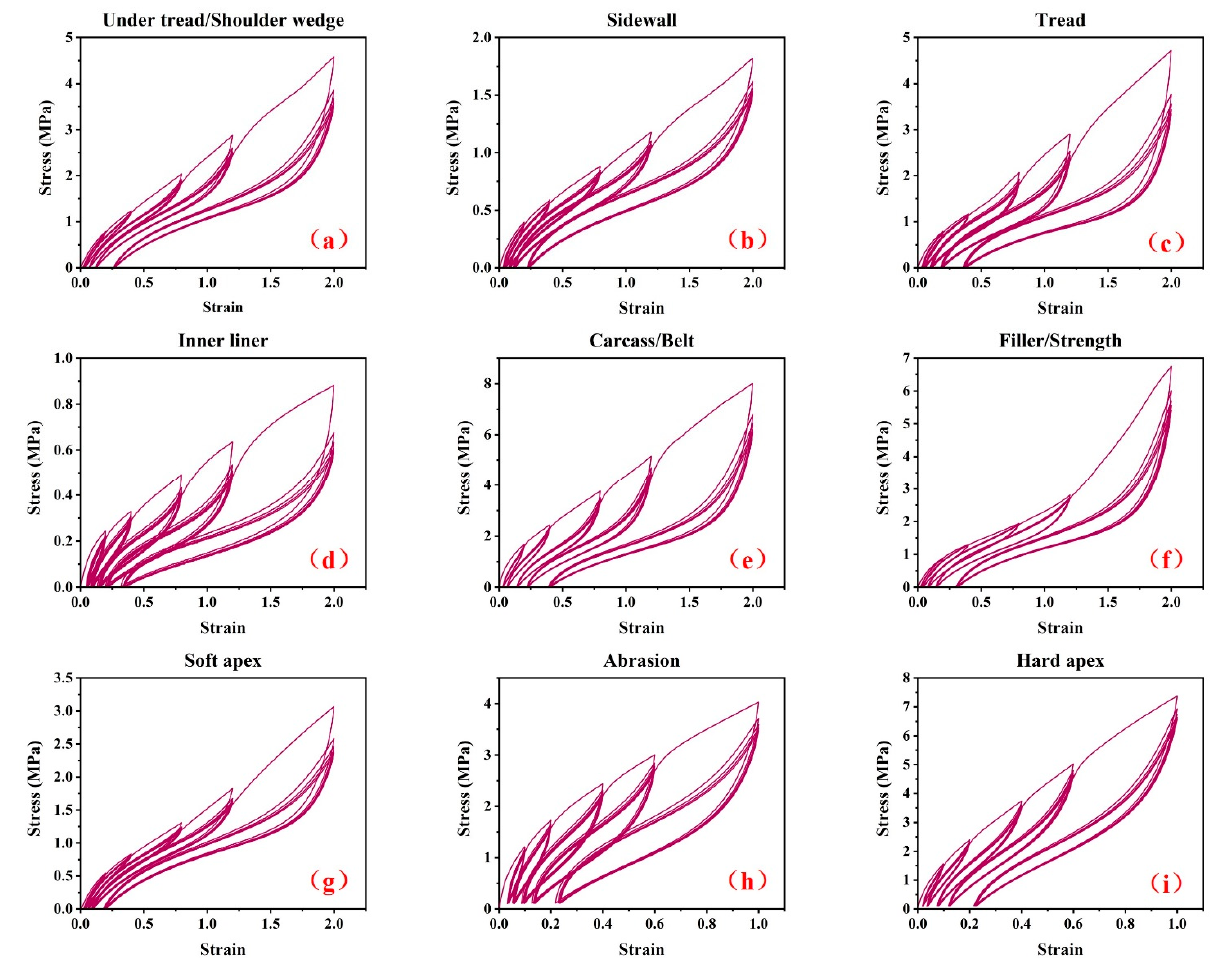
Figure 3. The raw stress–strain curves for nine different rubber specimens from TBR tire. ( a ) under tread and shoulder wedge, ( b ) sidewall, ( c ) tread, ( d ) inner liner, ( e ) carcass rubber and belt rubber, ( f ) filler rubber and strength rubber, ( g ) soft apex, ( h ) abrasion and ( i ) hard apex.